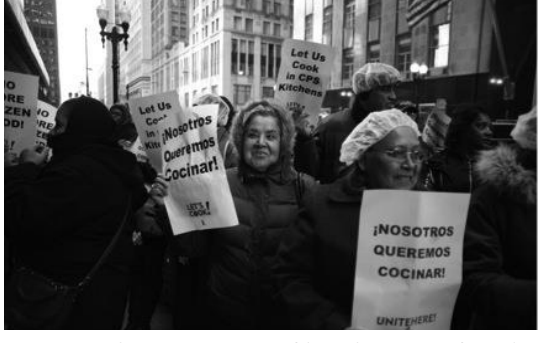
FIGURE 4: UNITE HERE LOCAL 1 CAFETERIA WORKERS DEMONSTRATING IN CHICAGO FOR THE RIGHT TO COOK IN SCHOOL CAFETERIAS. IMAGE COURTESY OF KYLE